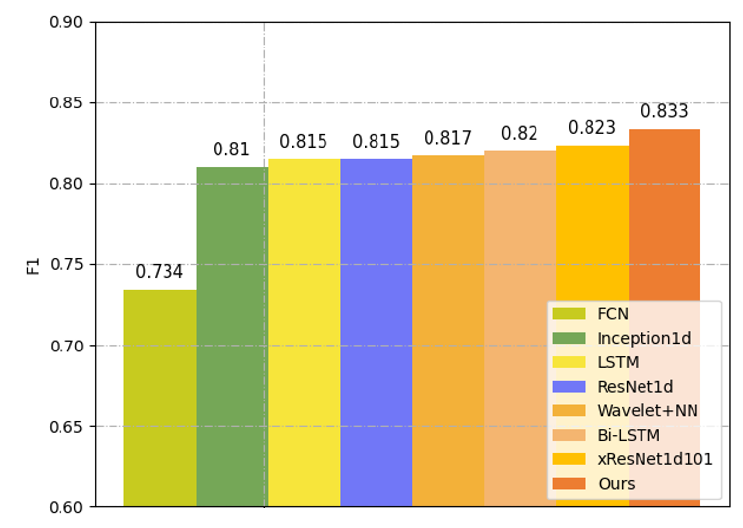
Figure 5. Classification performance of the proposed method and seven other methods (FCN [11], Inception1d [12], LSTM [35], ResNet1d [25], Wavelet+NN [13], Bi-LSTM [37], and xResNet1d101 [26]) on the PTB-XL